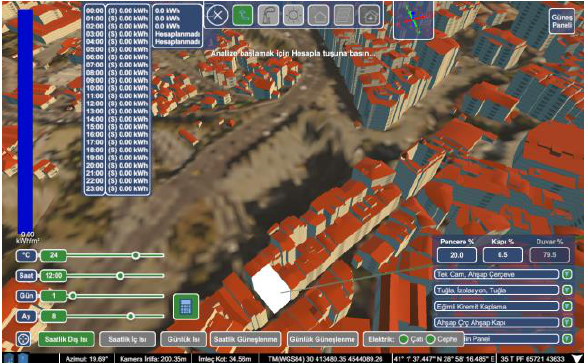
Figure 8. The implementation workflow.